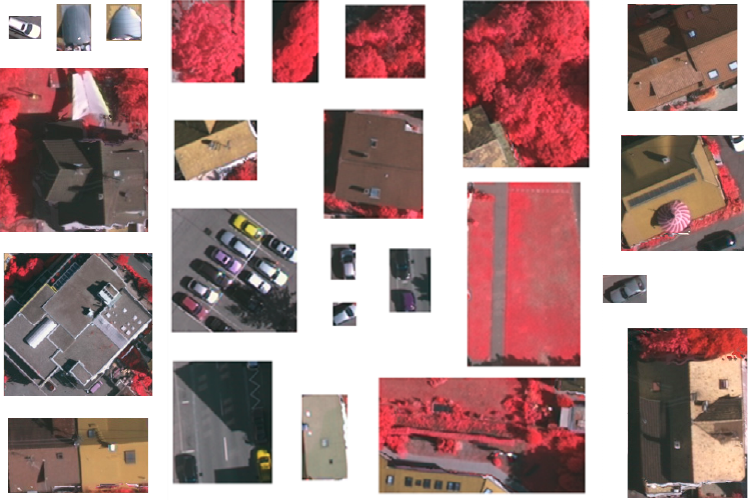
Figure 4. Images of bounding boxes of potential ground objects obtained using selective search, where width * height < 20,000, width/height < 5 or height/width < 5.